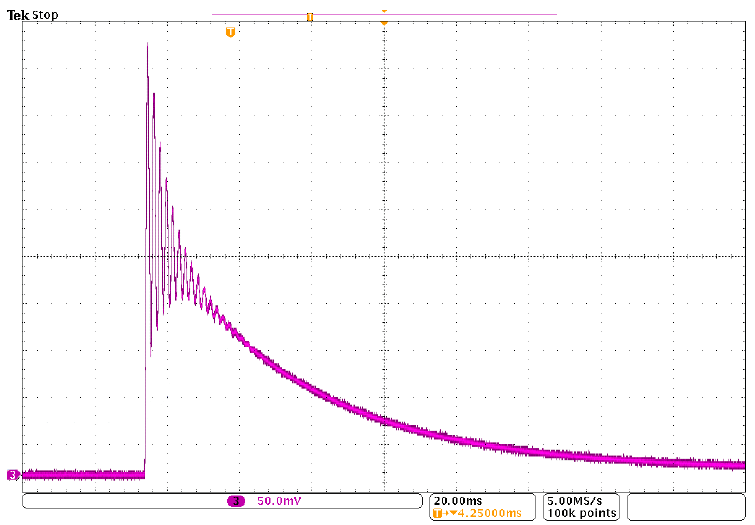
Figure 16. Oscillogram of u 2 ( t ) voltage at the output of a two-port network at the moment of its induction.